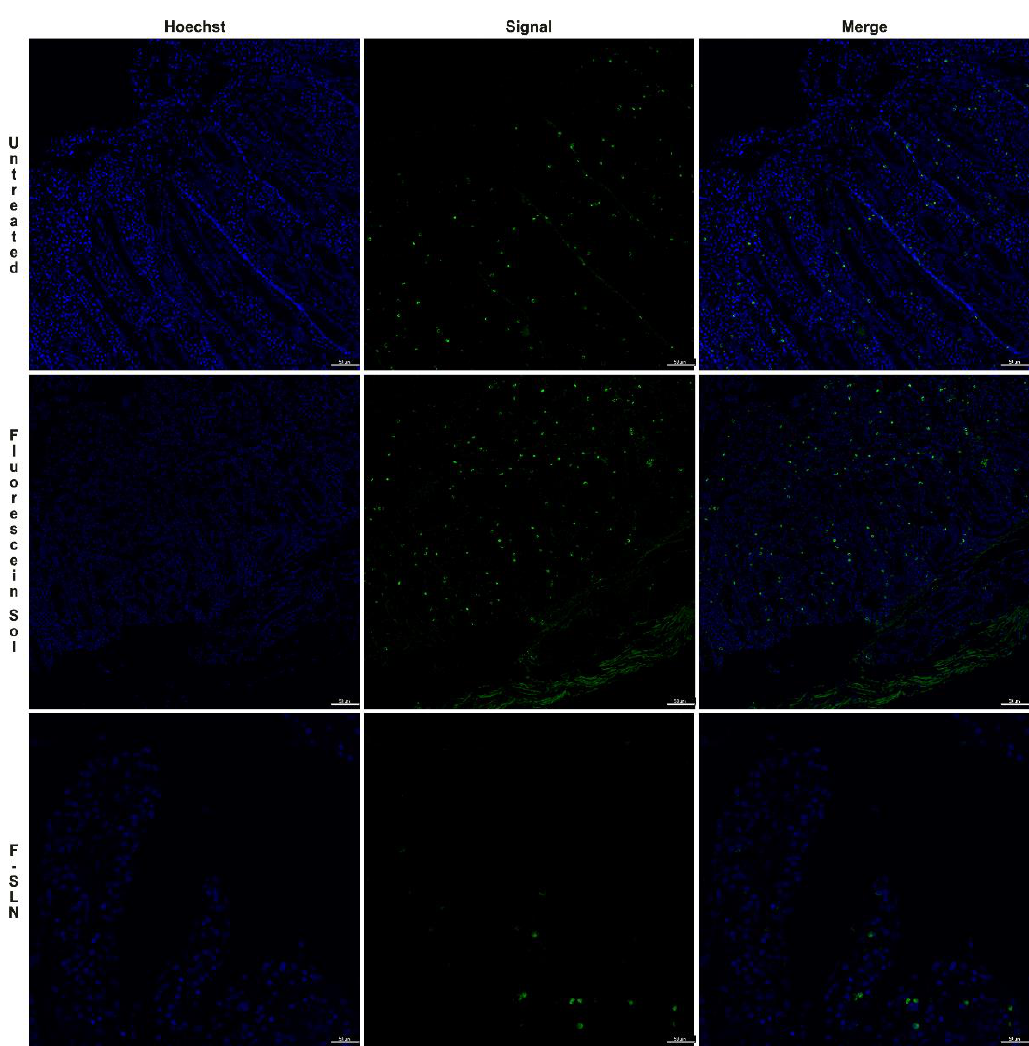
Figure 10. Ex vivo permeation test on intestinal tissue after 2 h: untreated intestinal mucosa, intestinal mucosa treated with free fluorescein solution, intestinal mucosa treated with F-SLN. Signals (green) / Hoechst 33342 nuclei (blue). Bar: 50 µm.